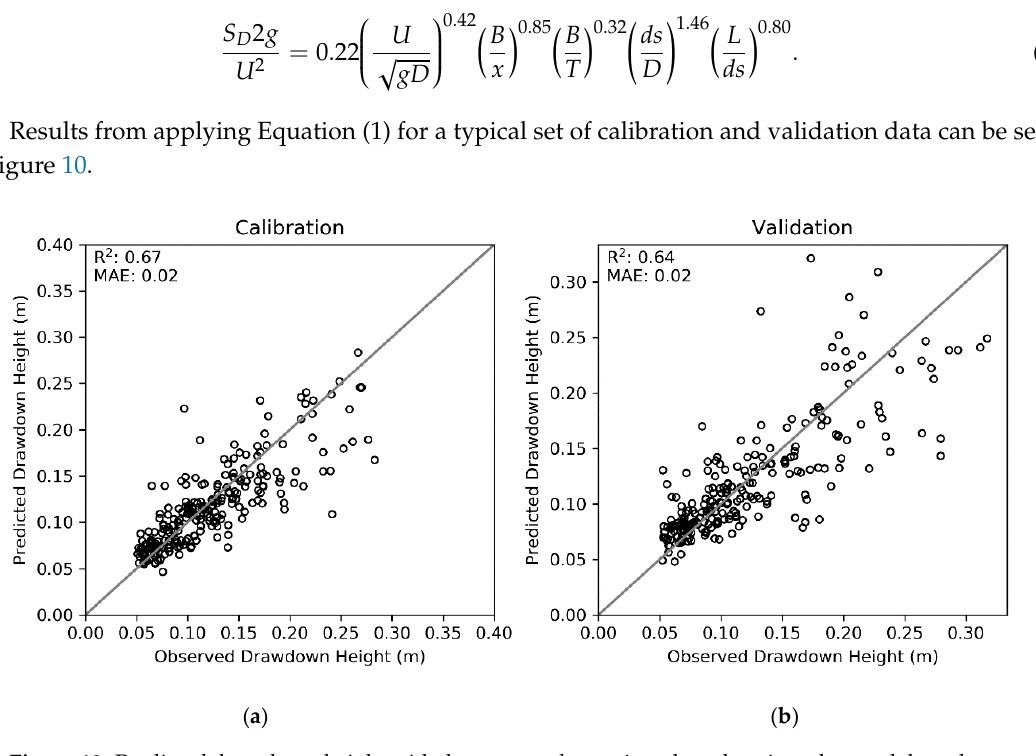
Figure 10. Predicted drawdown height with the proposed equation plotted against observed drawdown height for a typical data set used for calibration ( a ) and validation ( b ). The grey line displays the perfect fit between observed and predicted drawdown.